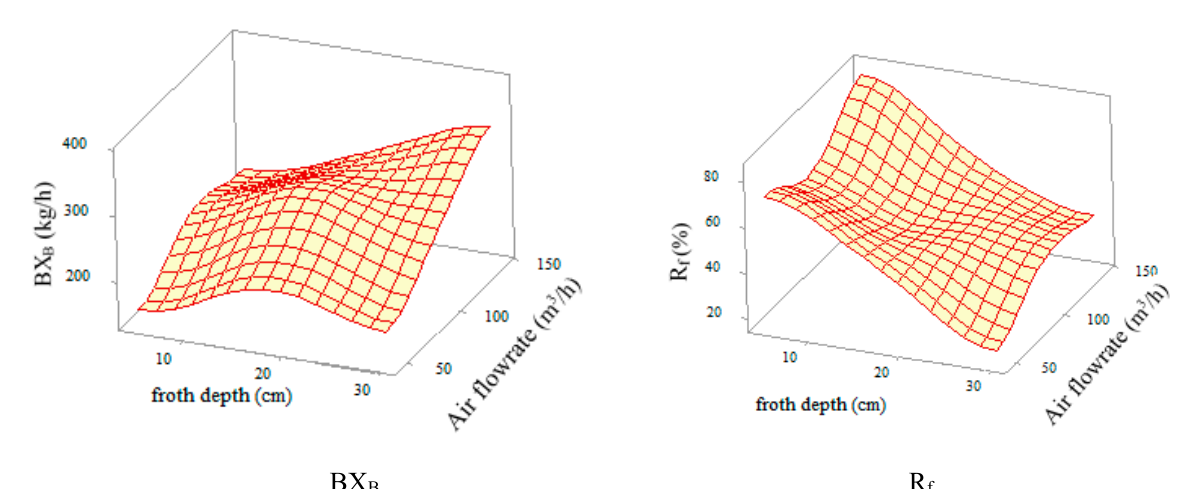
Figure 4. The response surface plots for the flowrate of the minerals into the froth phase (BX B ) and froth recovery (R f ) (the interaction for the collection zone recovery (R c ) was found to be nonsignificant).